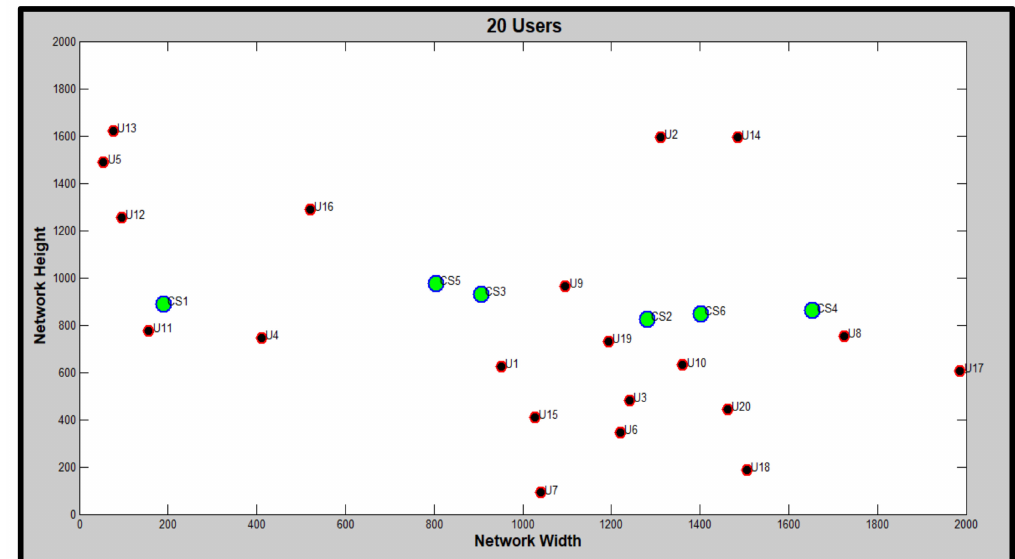
Figure 4. The architecture of the Fog Computing Model.